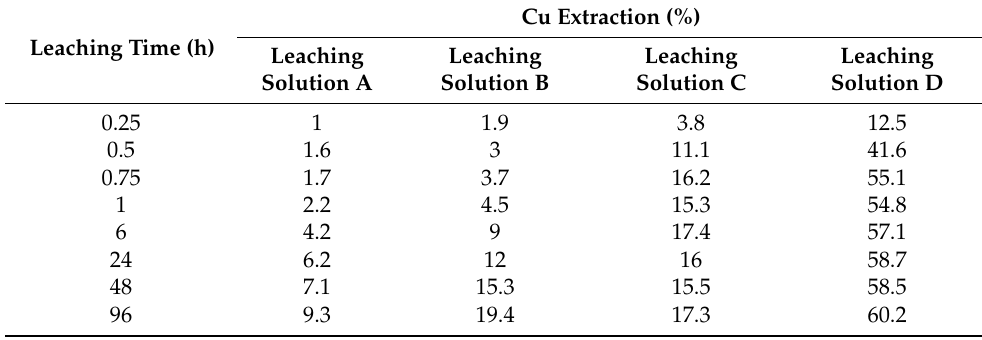
Table 4. Experimental results for leaching performed in the presence and absence of hydrogen peroxide.